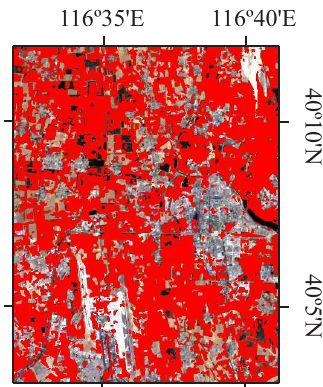
Figure 6: Pixels in red represent the changed areas detected by MSCVAPS method in the sub-area of China.